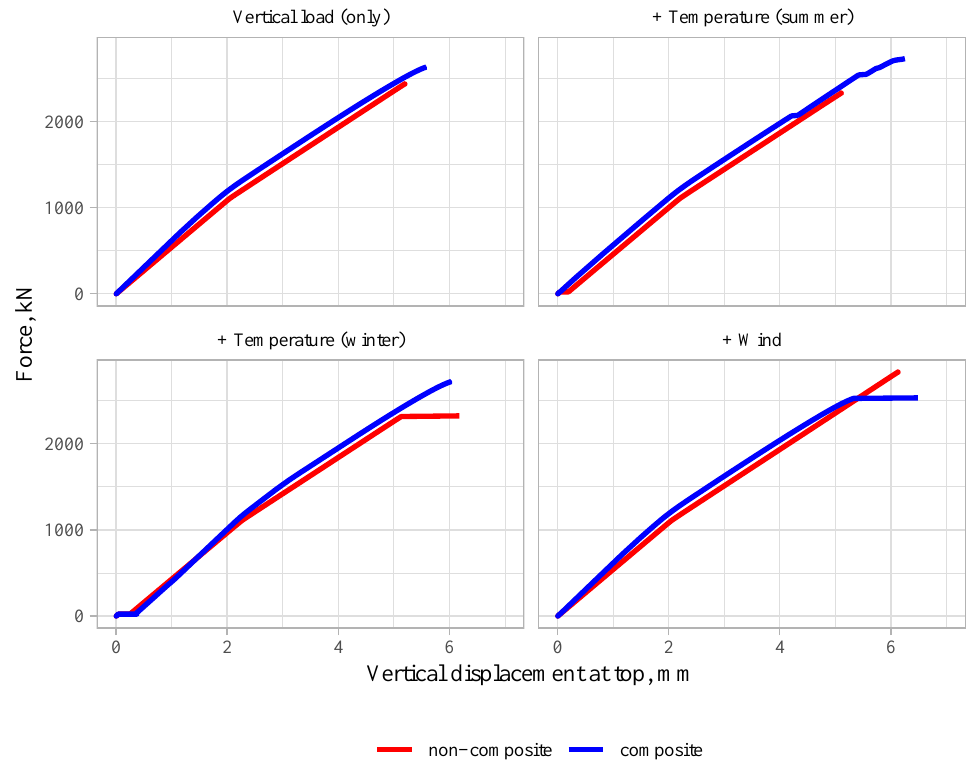
Figure 15. Load–displacement behaviour of exterior walls until failure in different load combinations.